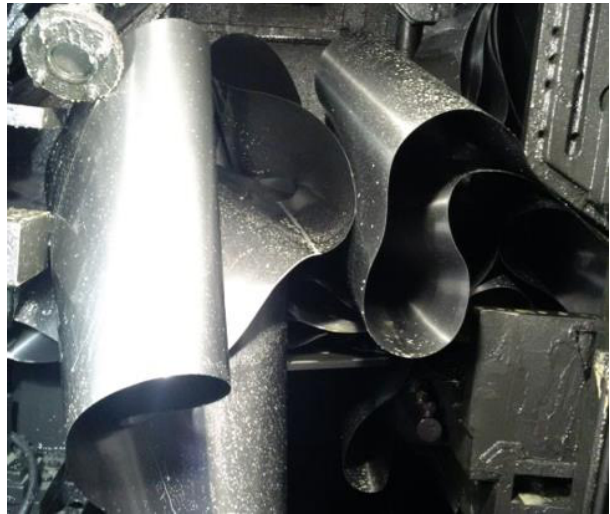
Figure 2. Consequences of strip rupture in the cold-rolling process.